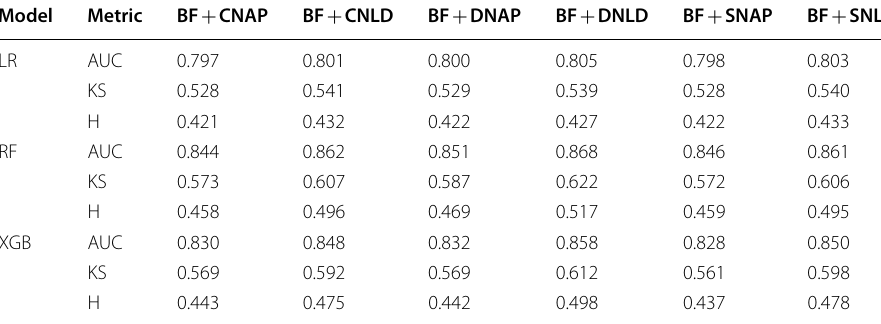
Table 37 Discrimination performance of different feature sets